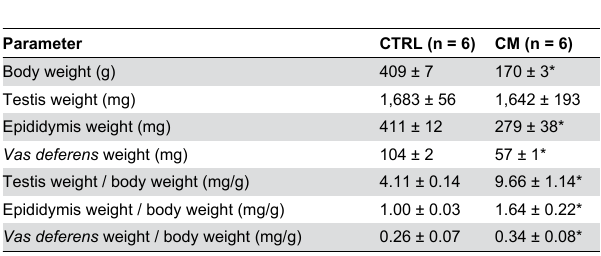
Table 1. Body weight, organ (testis, epididymis and vas deferens ) weight and organ/body weight ratio of CTRL male and CM male rats.